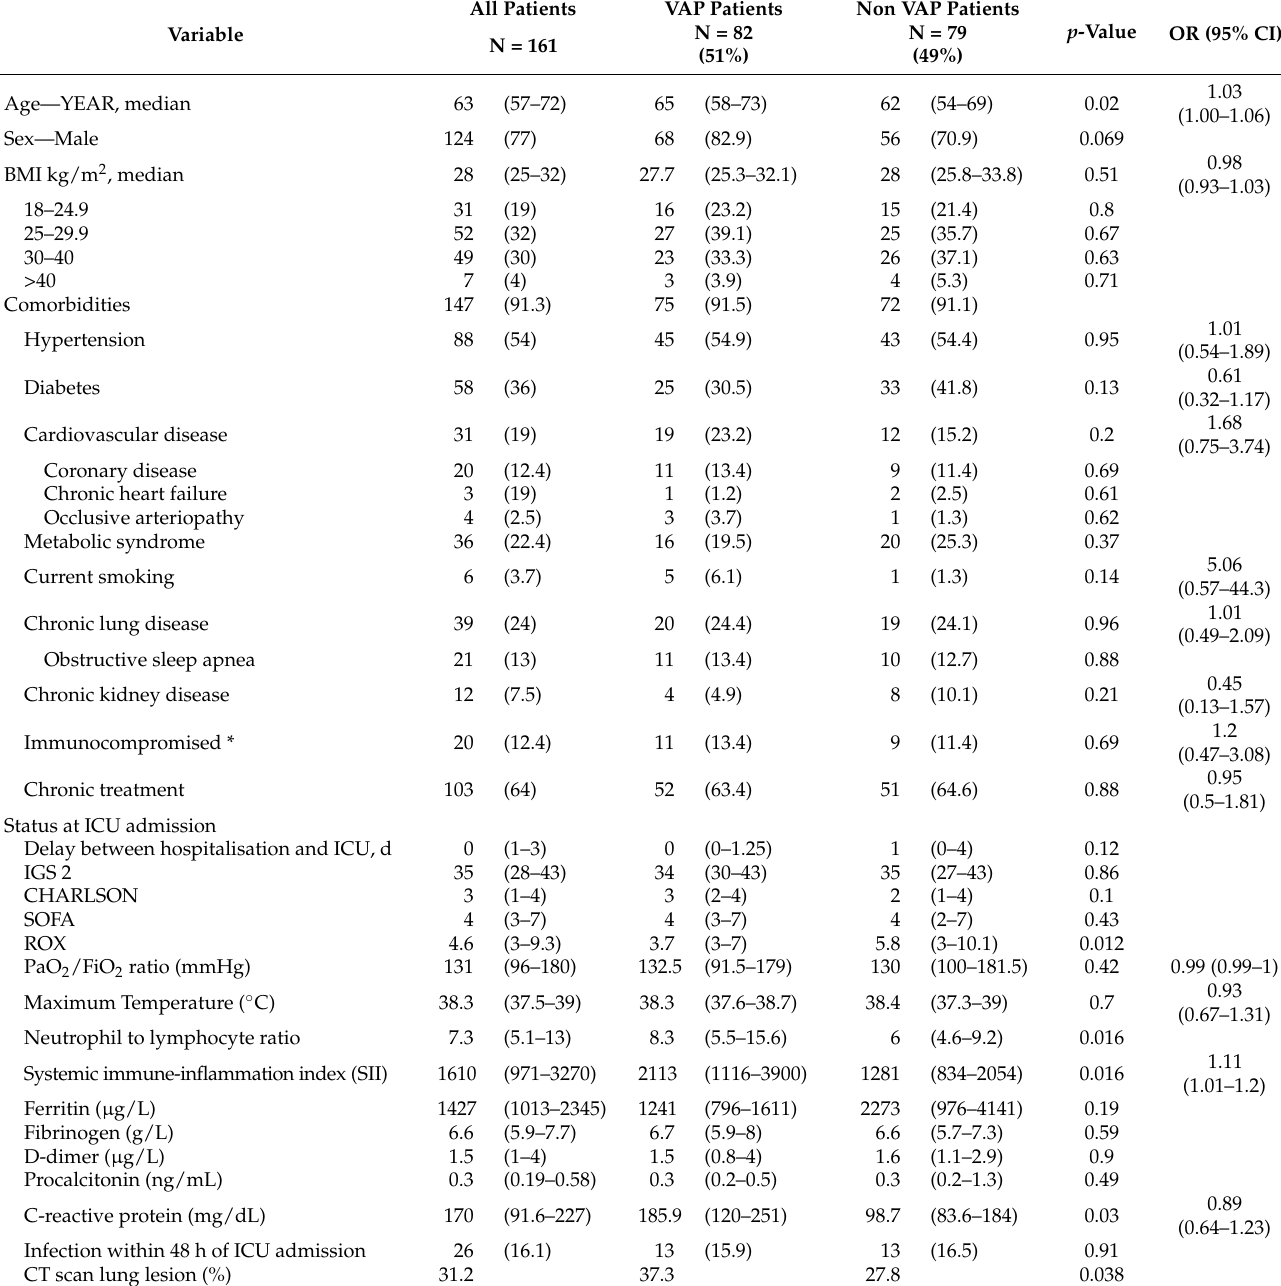
Table 1. Patient clinical and biological